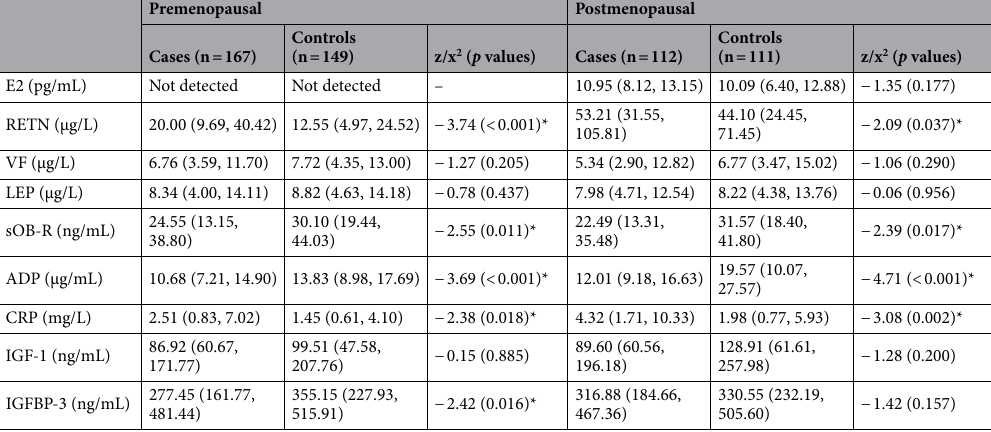
Table 1. The distribution and comparison of proteins among controls and cases of different menopausal status. Described as the median (25%, 75%) and rank sum test was used. E2 estradiol, LEP leptin, sOB-R soluble leptin receptor, ADP adiponectin, RETN resistin, VF visfatin, IGF-1 insulin-like growth factor 1, IGFBP-3 insulin-like growth factor binding protein 3, CRP C-reactive protein. * p < 0.05.